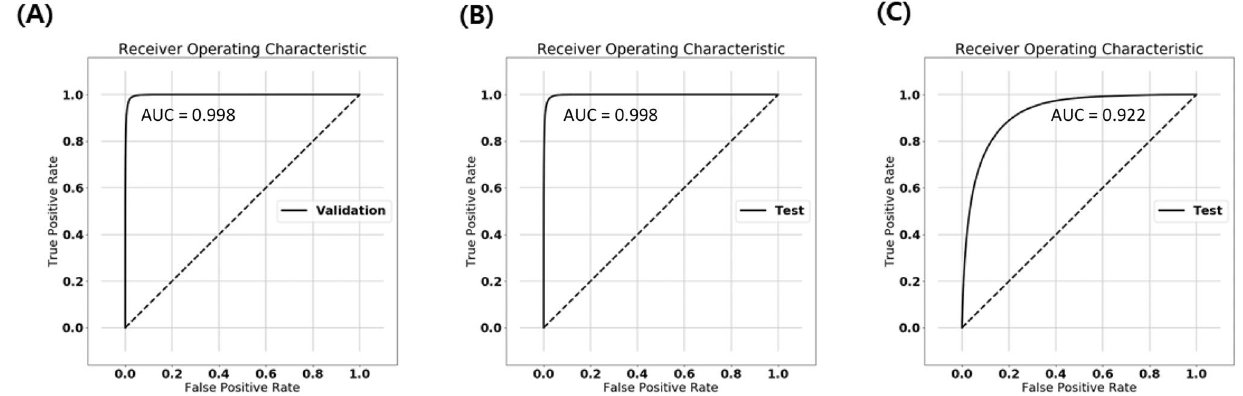
Figure 4. Receiver operating characteristic curves of ( A ) internal validation, ( B ) internal testing, and ( C ) external testing.